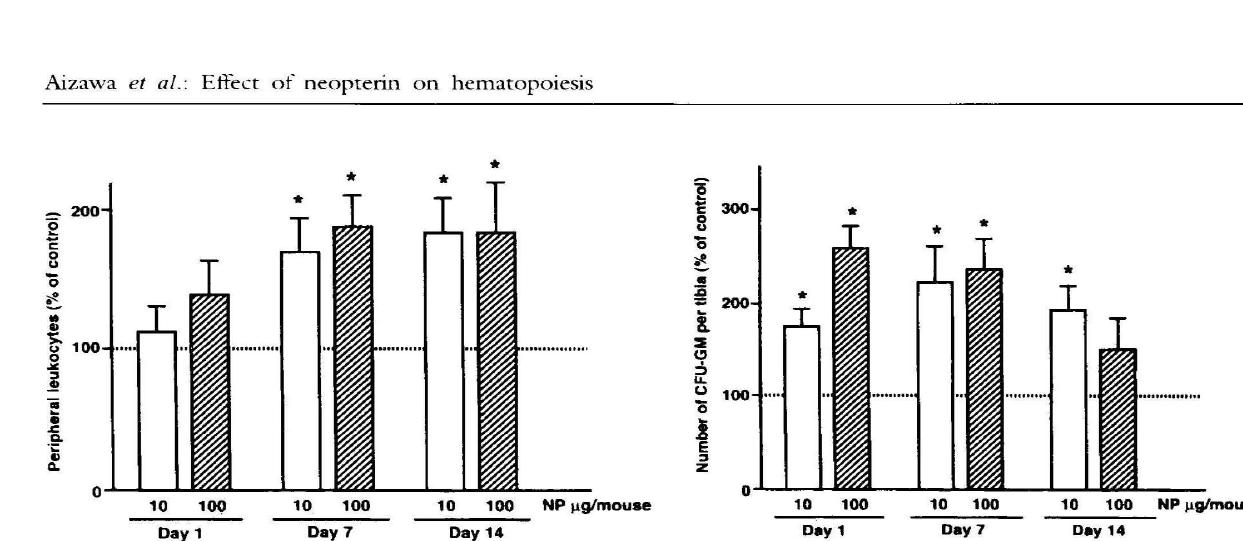
Figure 3. The number of CFU-GM in bone marrow af ter NP treatment. Bone marrow cells were obtained 1, 7 and 14 days after NP treatment and changes in the number of CFU-GM were assayed. The results are ex pressed as a percentage of the control. Each bar repre sents the mean±SD obtained from five mice individually analyzed. *Significant increase (p<O.05) with respect to NP non-treated mice.